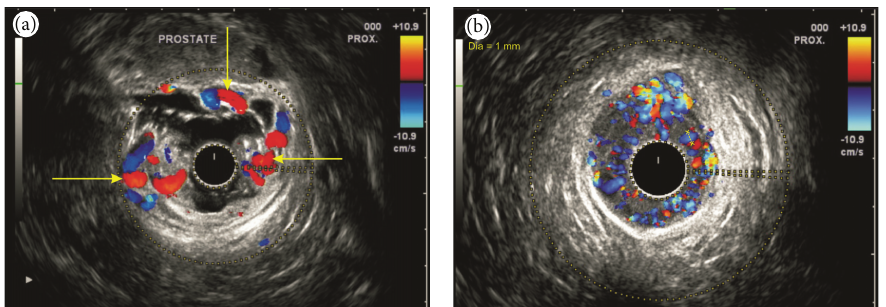
Figure 3: (a) As the scope is withdrawn towards the lower rectum, the submucosal varices were seen in anterior and lateral wall of rectum. (b) As the scope is pulled through the anus multiple small perforators < 1mm diameter were seen going through the muscular layer of anal